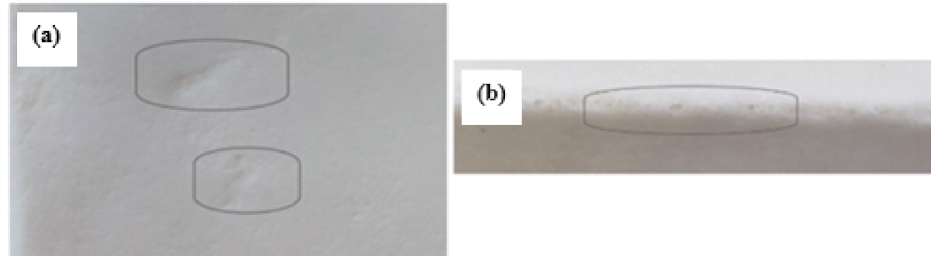
Figure 6. Photographs of surface defects in ( a ) wall and ( b ) corner of a thin-walled moulding containing 15 wt.% of quartz flour